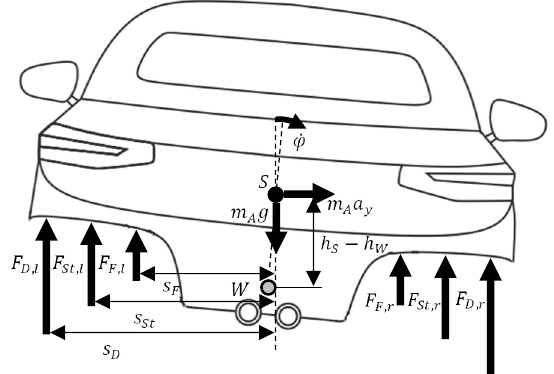
Figure 2. Description of the construction of the rolling dynamics.